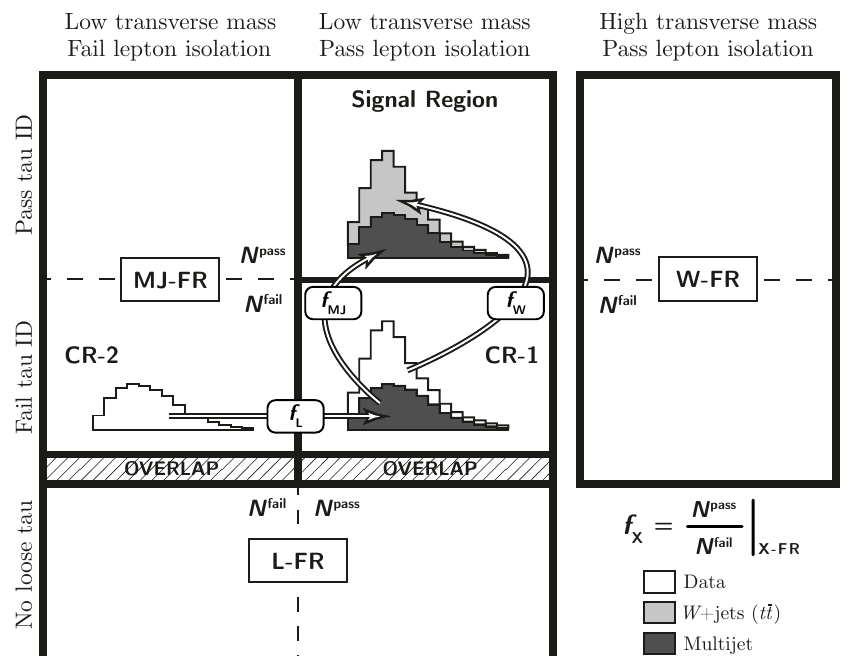
Figure 3. Schematic of the fake-factor background estimation in the (cid:28) lep (cid:28) had channel.